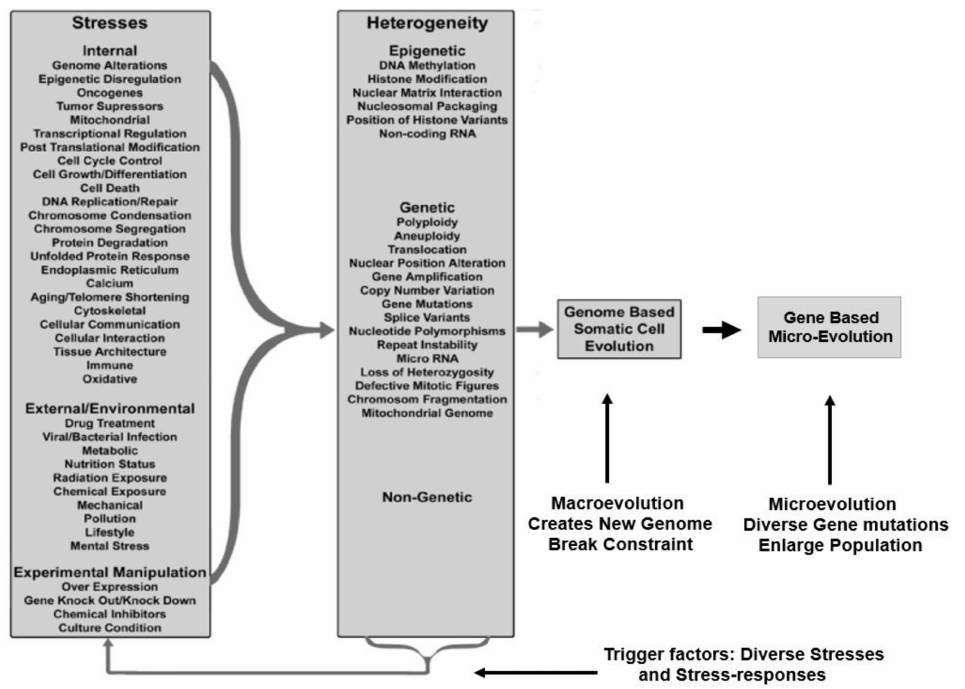
Figure 1. An illustration of the molecular mechanisms and their relationship with stress, genomic system response, macro- and micro-evolution, and genomic / environmental constraints. In the column of “Stresses”, each item, such as cell cycle control, could involve hundreds of gene mutations, and each mutation can represent a specific molecular mechanism. In the column “Heterogeneity”, di ff erent types of stress response can again involve vast amounts of di ff erent genomic and non-genomic factors or mechanisms. The types of genetic and non-genomic variations also include indels, duplications, and mobile elements [42]. Thus, the trigger factors are too numerous to handle. The key for cancer evolution can be understood as two main steps as soon as evolution is initiated: genome alteration-based macro-evolution followed by cancer gene mutations / epigenetic-based